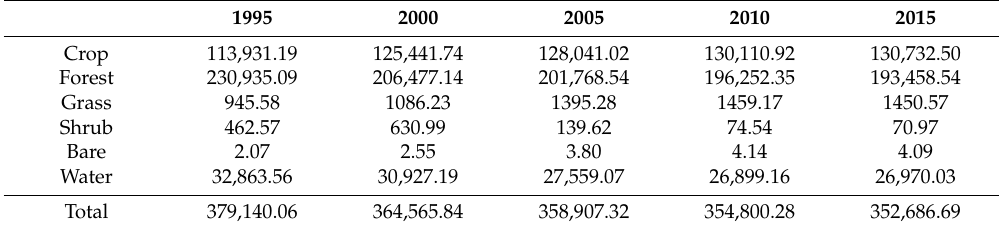
Table 5. Ecosystem service values of Jiangxi province from 1995 to 2015 (unit: 10 6